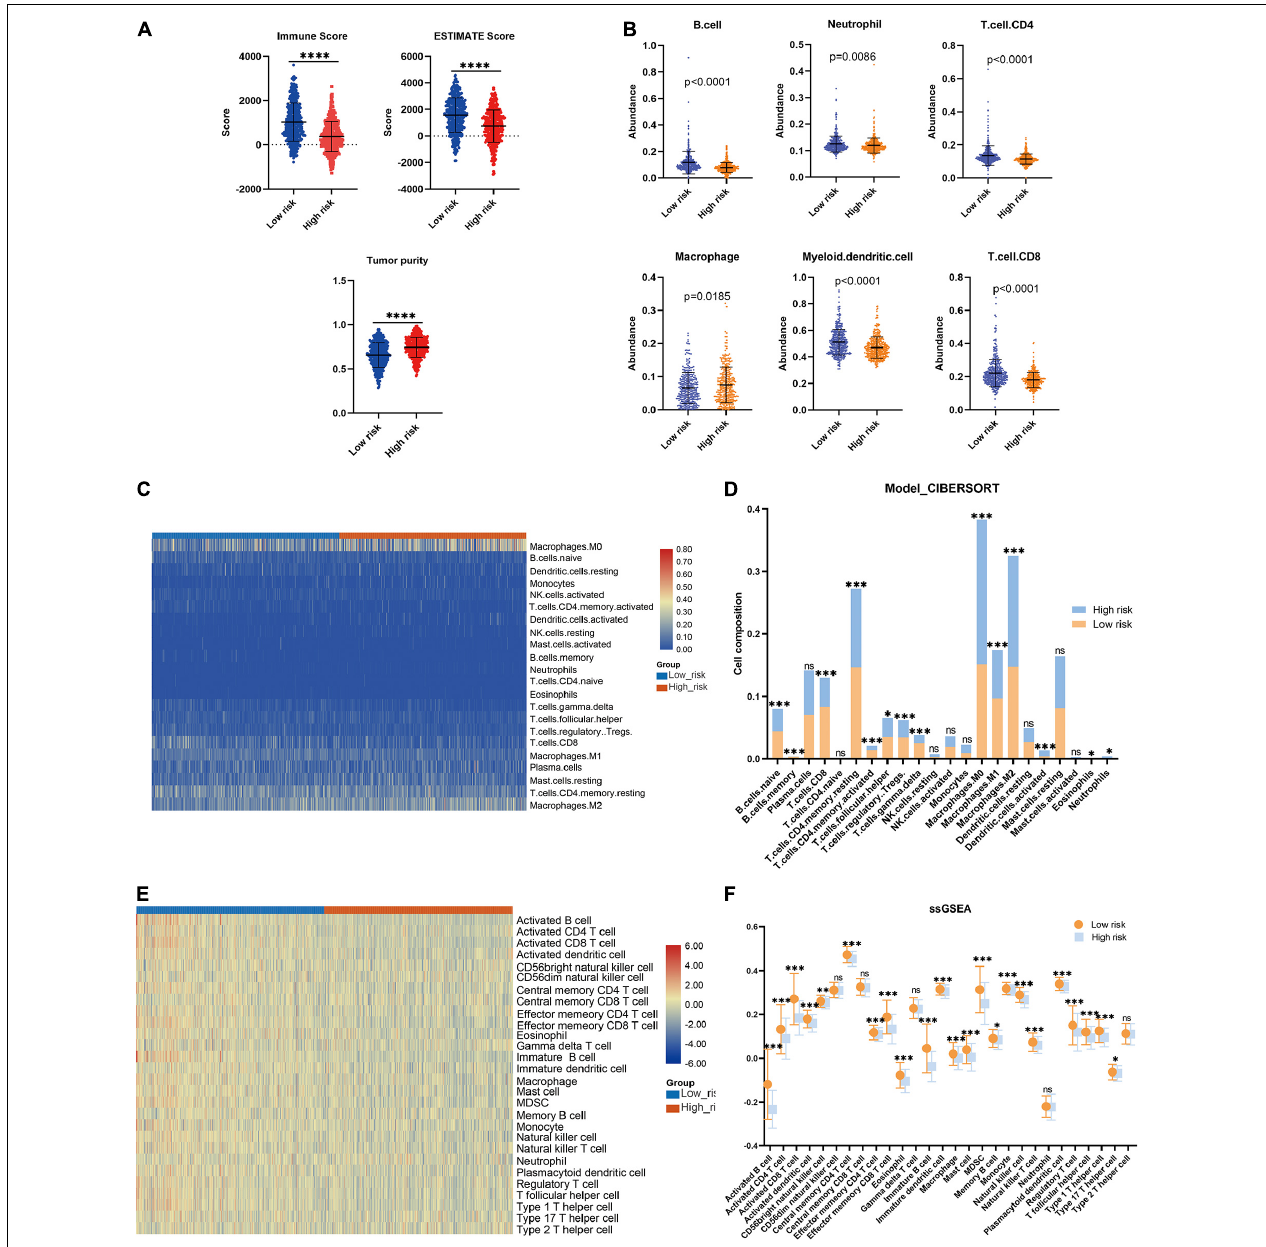
FIGURE 5 | Immune microenvironment landscape in the training cohort. (A) ESTIMATE algorithm, (B) TIMER algorithm, (C,D) CIBERSORT analysis, and ssGSEA analysis (E,F) . * p < 0.05, ** p < 0.01, *** p < 0.001, **** p < 0.0001.